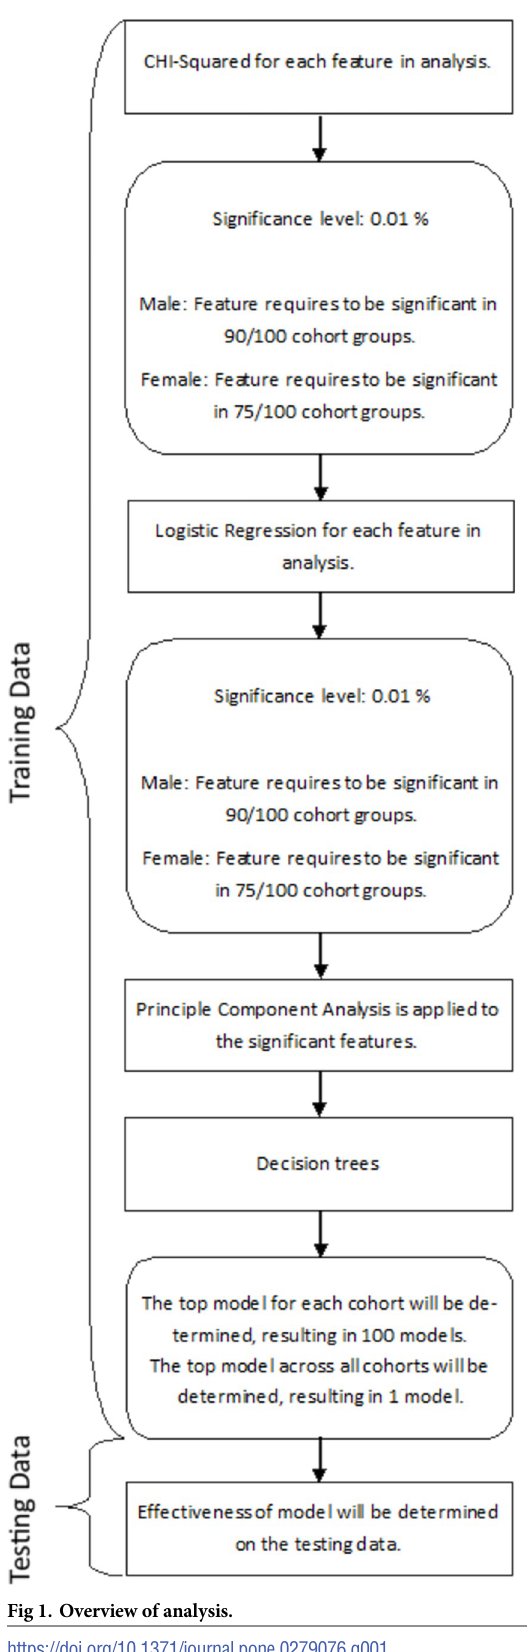
Fig 1. Overview of